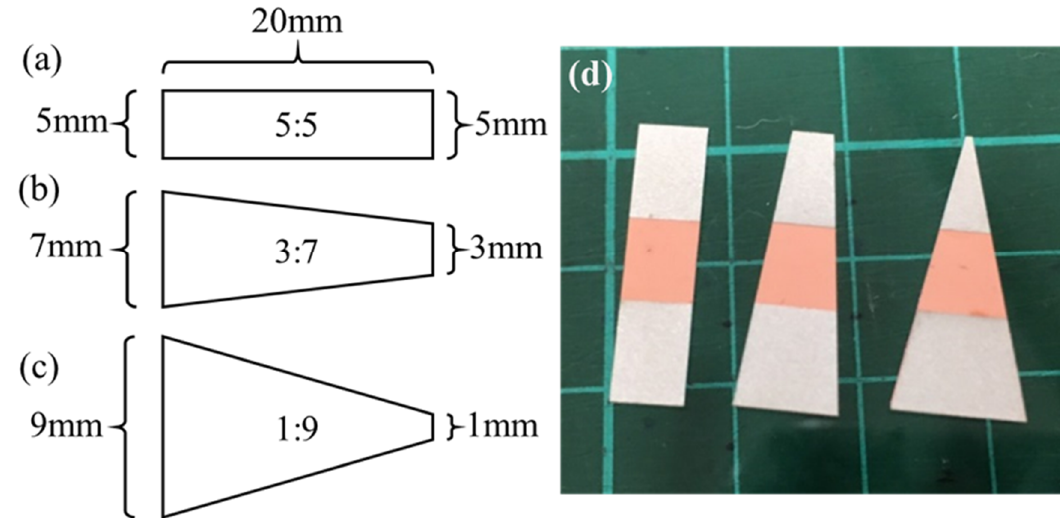
Figure 2. The sample was cut into three different sizes: ( a ) 5:5 size; ( b ) 3:7 size; ( c ) 1:9 size; ( d ) actual samples. Table 1. Conditions for electroplating tin and copper films.